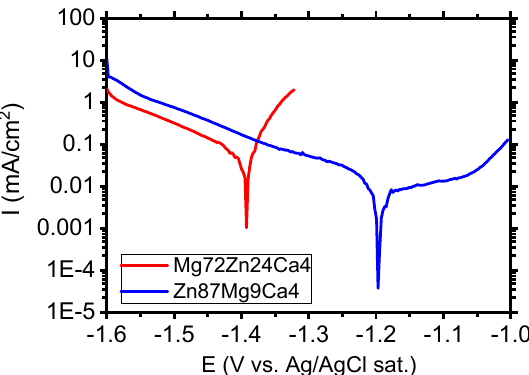
Figure 9. Polarization curves performed for Mg 72 Zn 24 Ca 4 and Zn 87 Mg 9 Ca 4 alloys in Ringer’s solution at 37 ° C, pH 7.2.